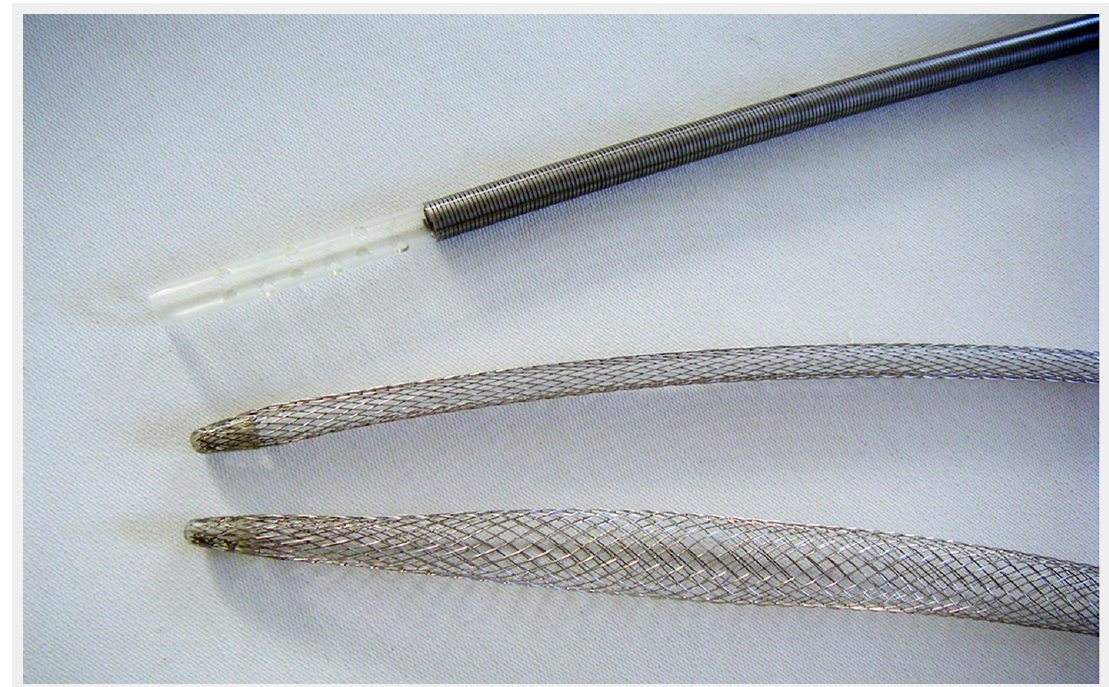
Figure 3 Thin wall percutaneous cannula (top), collapsed virtually wall-less cannula prior to insertion (centre), and virtually wall-less cannula expanded in situ